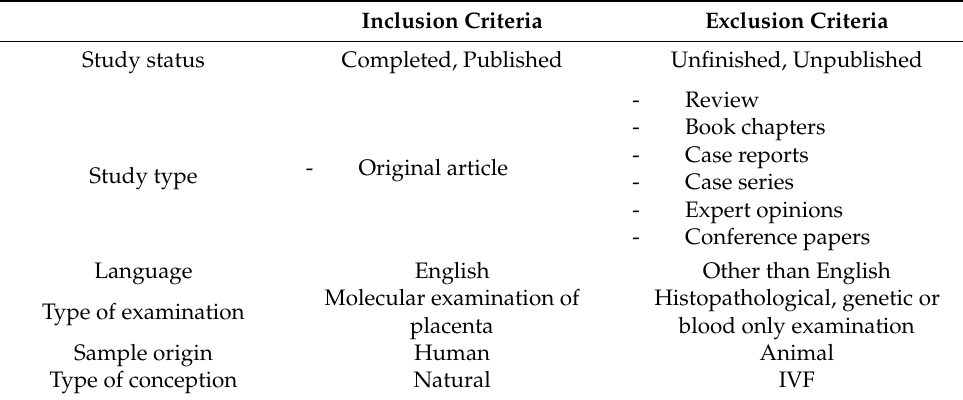
Table 1. The inclusion and exclusion